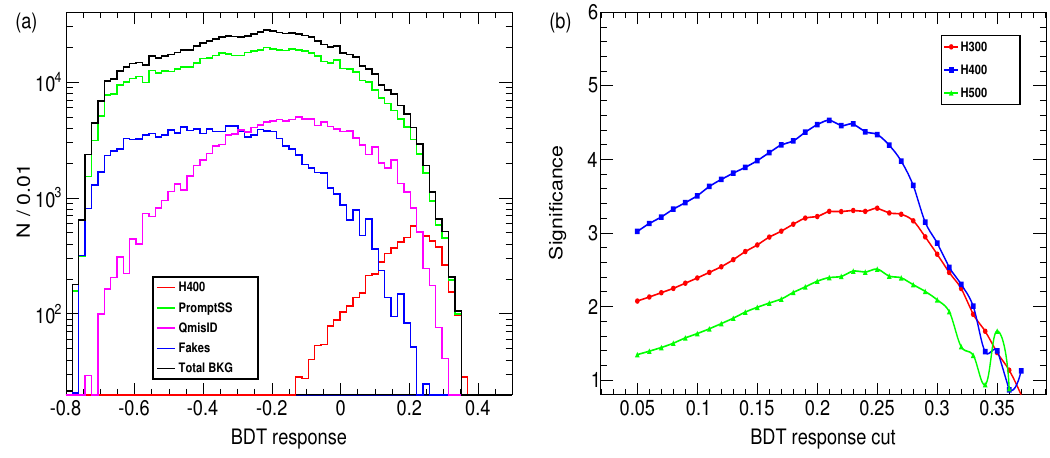
Figure 7 . BDT optimization for Higgs signals over backgrounds. Plot-(a) depicts the distributions of the output BDT response for the Higgs signal of M Plot-(b) presents the signi(cid:12)cance Z as a function of the BDT cut for M shown by (red, blue, green) curves. The optimal BDT cuts are (0.25, 0.21, 0.25) for the three curves of M = (300 ; 400 ; 500) GeV, which correspond to the maximal signi(cid:12)cance Z = (3 : 3 ; 4 : 5 ; 2 : 5). H We input an integrated luminosity of (300, 1000, 3000)fb (cid:0) 1 for M